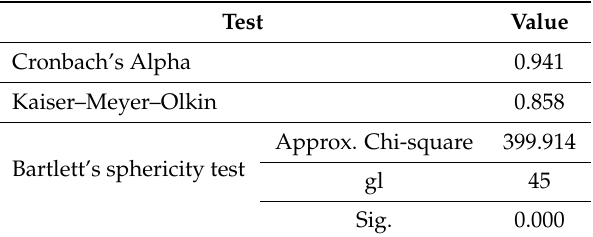
Table 5. Cronbach’s Alpha, KMO and Bartlett tests